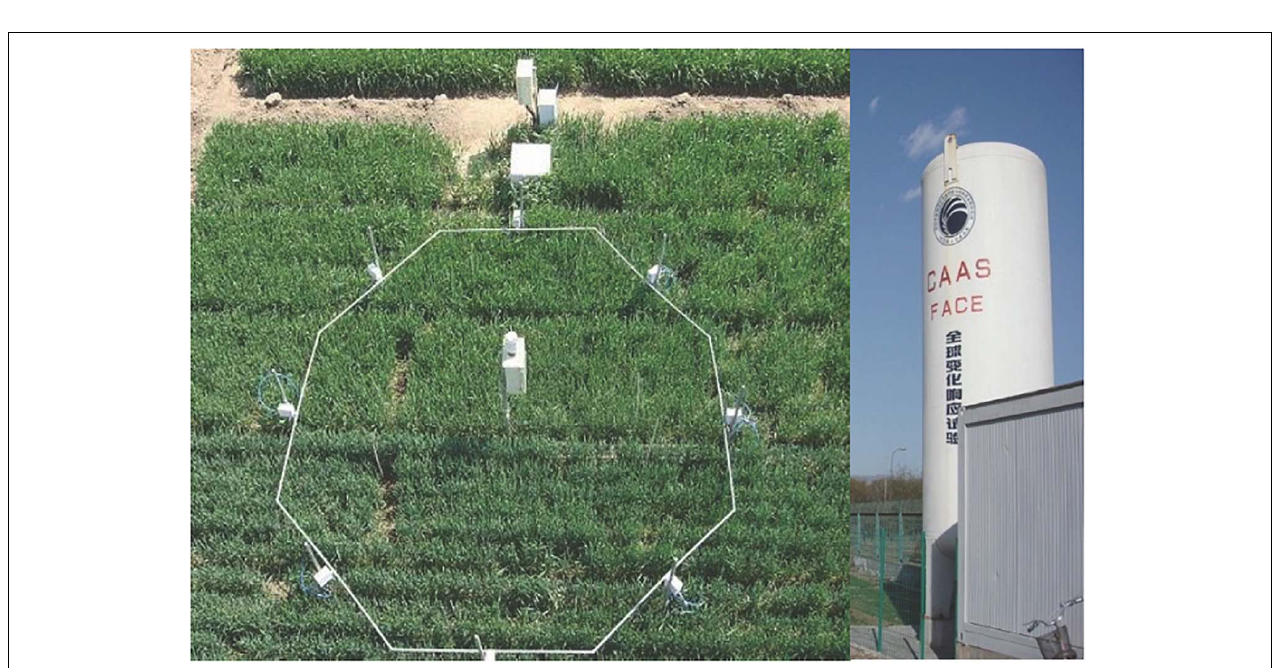
FIGURE 2 | Mini-free air carbon dioxide enrichment system of Chinese Academy of Agricultural Sciences (CAAS-FACE system) in Changping, Beijing, China.